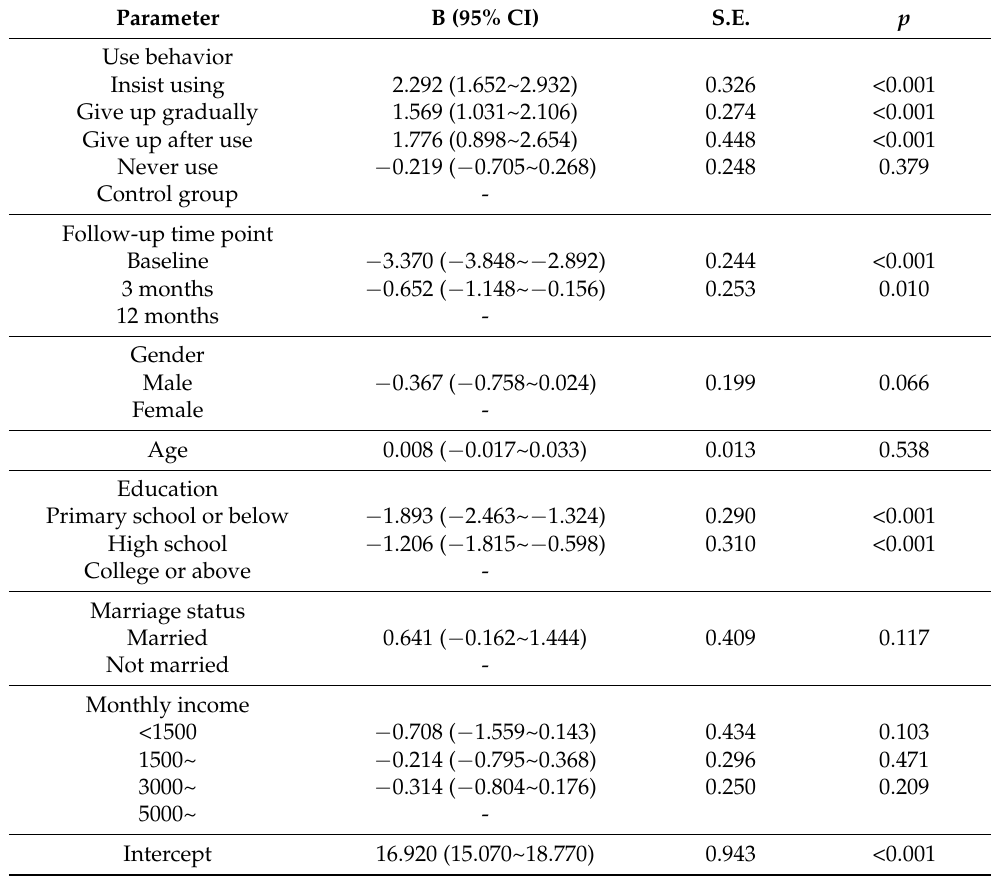
Table 3. The influence of the guiding booklet use on dietary